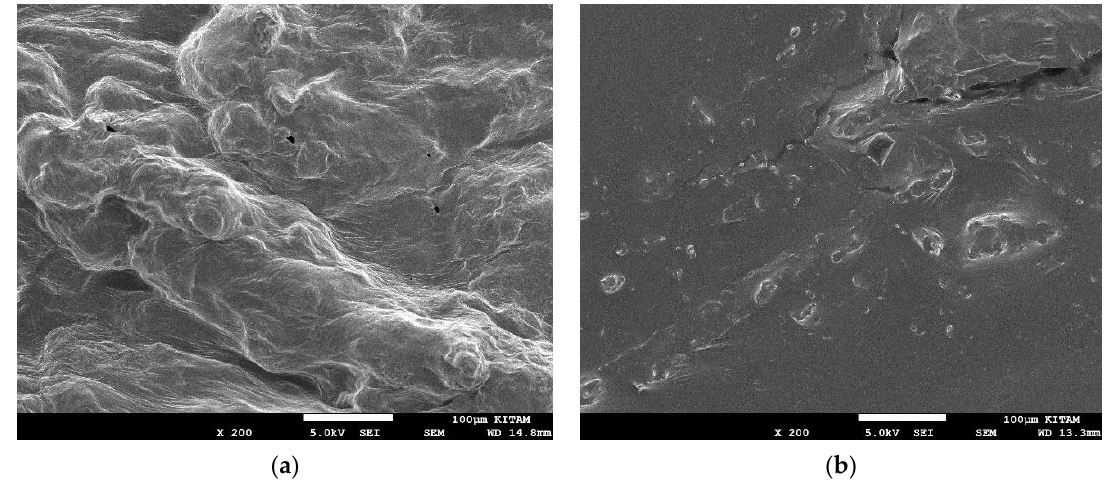
Figure 2. Microstructures of fresh ( a ) and osmo-dehydrated ( b ) autumn olive berries.